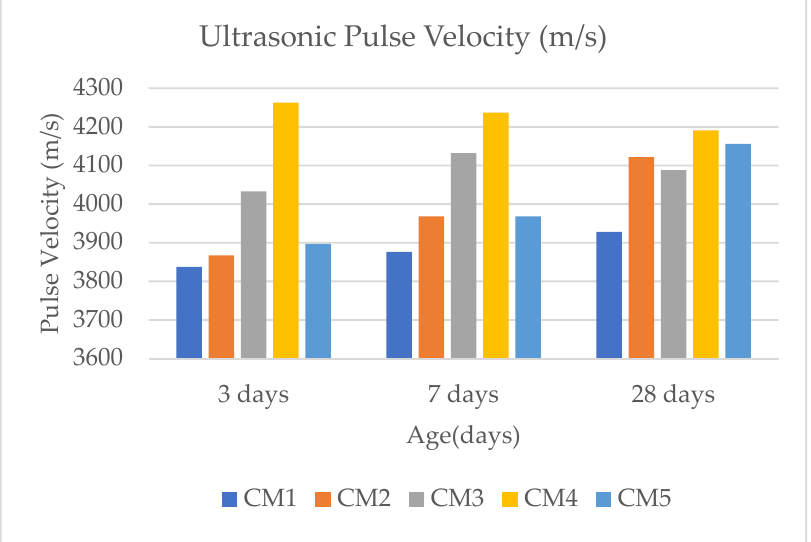
Figure 12. Ultrasonic pulse velocity of CM-UFS-GO composites.